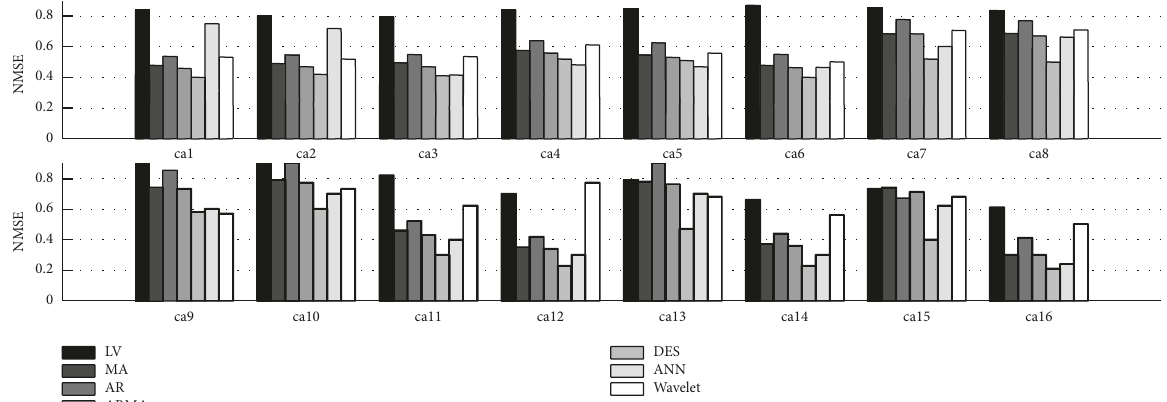
Figure 6: Normalized mean square error of different predictors for CAIDA traces. The prediction interval used is 100 milliseconds.